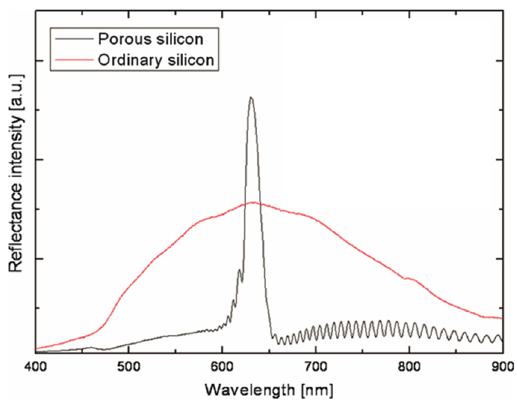
Figure 18. The comparison of the reflected intensity light between ordinary silicon and multi-layer-Psi. Adapted from